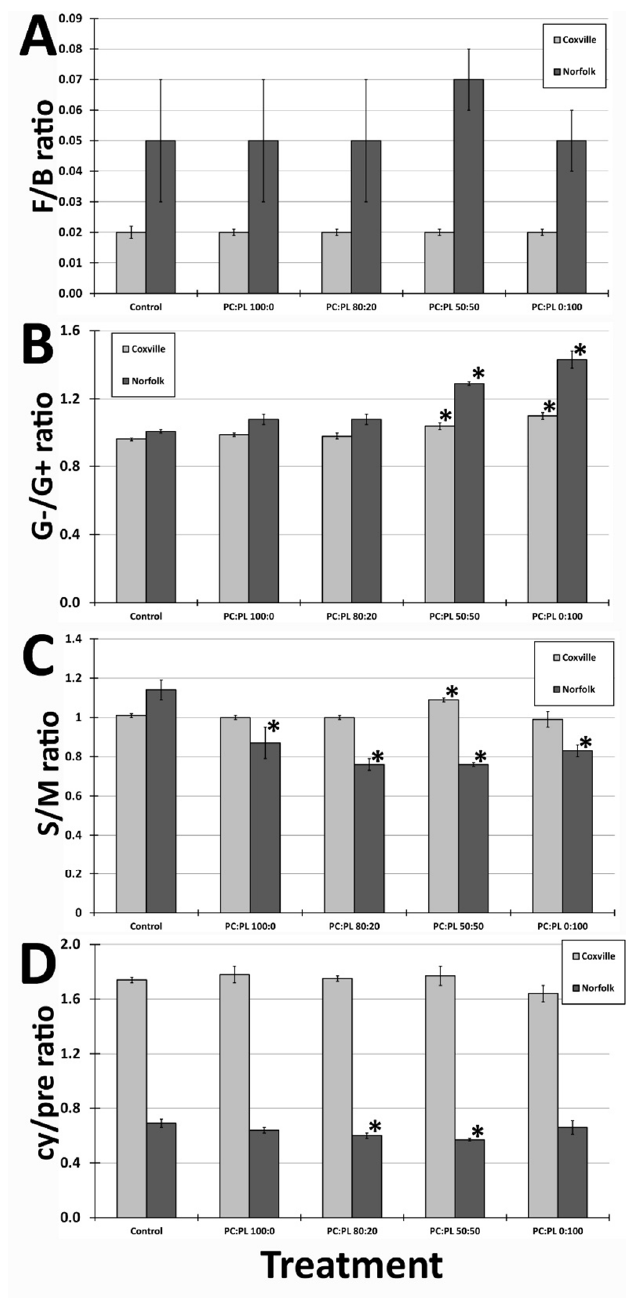
Figure 2. Ratios between PLFA groups in treatment soils. Data are means and standard deviations ( n = 3). Panels are as follows: ( A ) fungal to total bacterial PLFAs (F/B); ( B ) Gram-negative to Gram-positive bacterial PLFAs (G − /G+); ( C ) saturated to monosaturated PLFAs (S/M); and ( D ) cyclopropyl to precursor PLFAs (cy/pre). * indicates statistical significance of biochar treatment comparative to the control treatment of the same soil